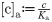
Distributions from stochastic simulations and the corresponding deterministic phase portraits.Apart from [c]a, the parameters are the same as in Table 1. The phase portraits were obtained from the deterministic system similarly to those presented in the previous sections. For the distributions, the simulations were run 5000 times for 106 s each (simulated time) and started at a mRNA, protein and intracellular xanthosine count of 0. We show the two cases of unimodality (low expression in (A) and high expression in (C)) as well as the case of bimodality in (B). The values of [c]a are 12 in (A), 18.5 in (B), and 25 in (C) (recall that [c]a≔cKa with Ka = 5 ⋅ 10−5 M, so [c]a is dimensionless). The output from the stochastic simulations is in good agreement with the concentrations at the fixed points in the deterministic phase portraits.